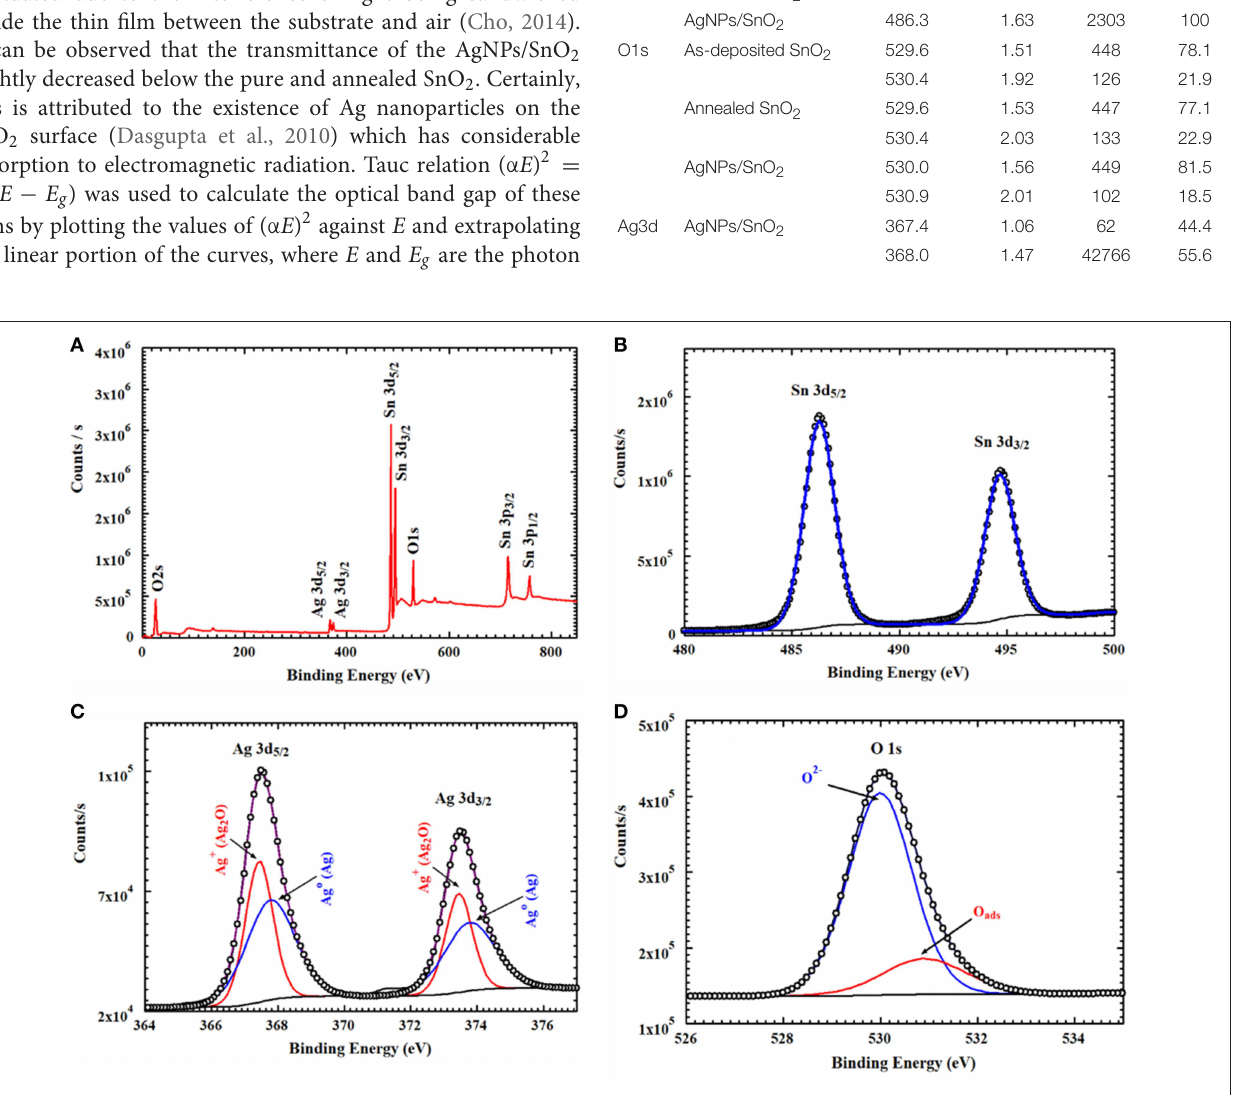
Frontiers in Materials |